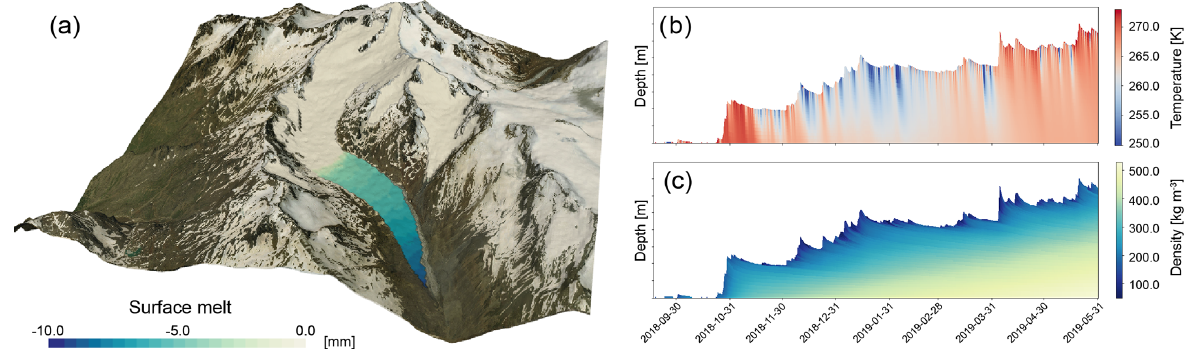
Figure 4. Operational application of COSIPY for the Hintereisferner. Panel (a) shows the forecast of surface melt for 22 June 2020 based on COSMO2 data. Panels (b) and (c) show an example of the temperature and density profile for one site on the glacier tongue for the period of September 2018 to June 2019.